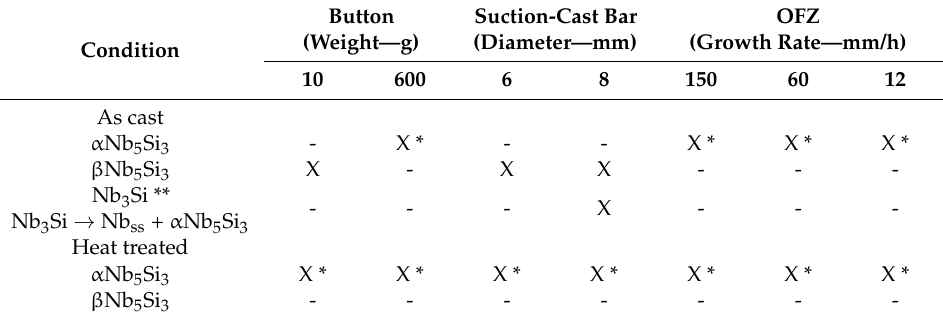
Table 1. Summary of data for type(s) of silicide(s) in alloy CM1.